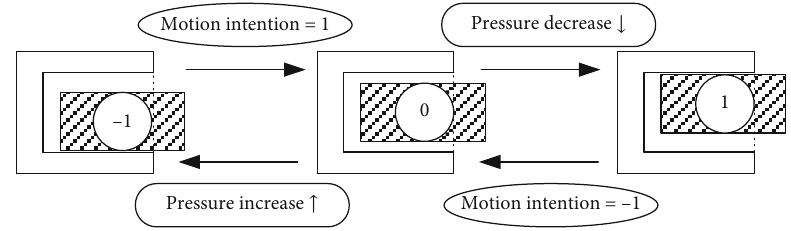
Figure 8: Schematic of a backlash touch state update.